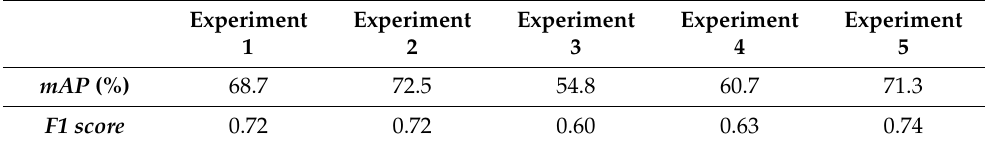
Table 14. Results of YOLOv5n on CCTSDB2021